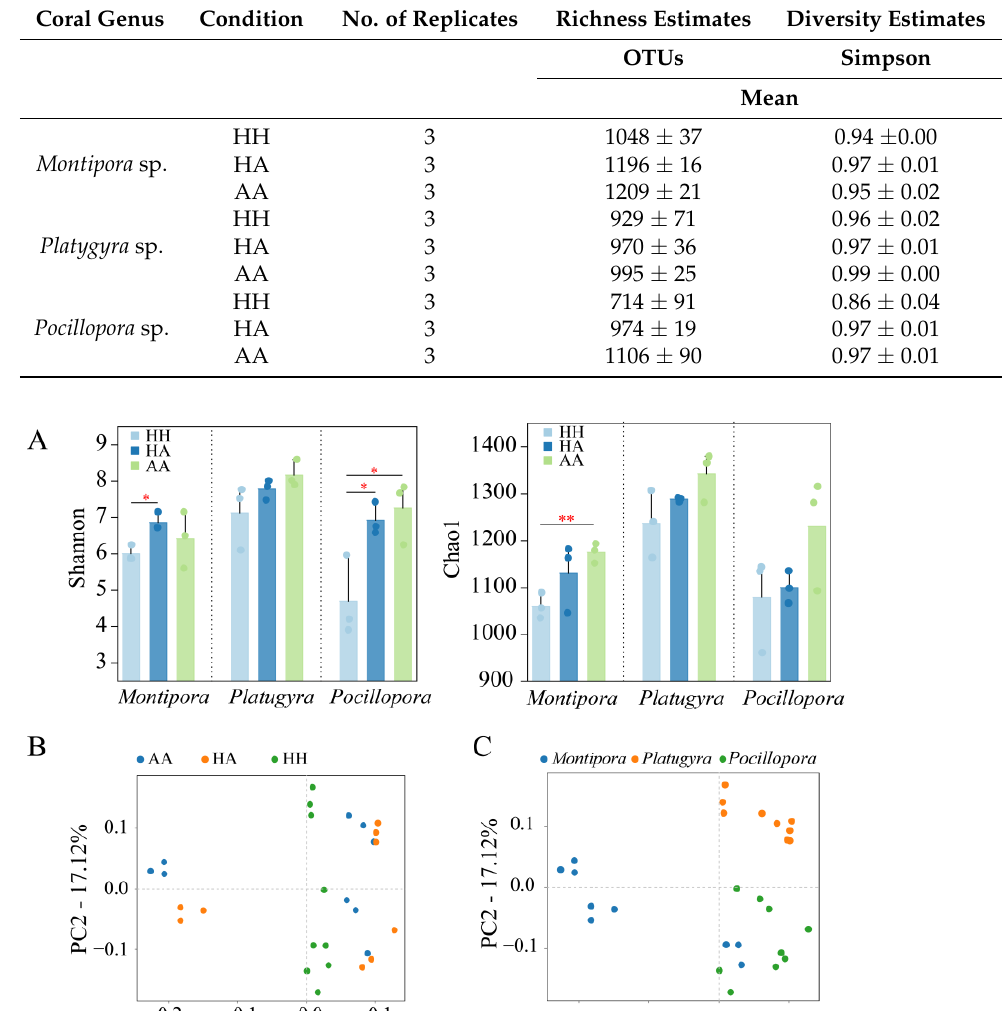
Table 1. Richness and Diversity estimates of bacterial 16S rRNA sequencing data of coral samples. HH: the non-algae part; HA: the junction of the non-algae part and the algae part; AA: the algae part.